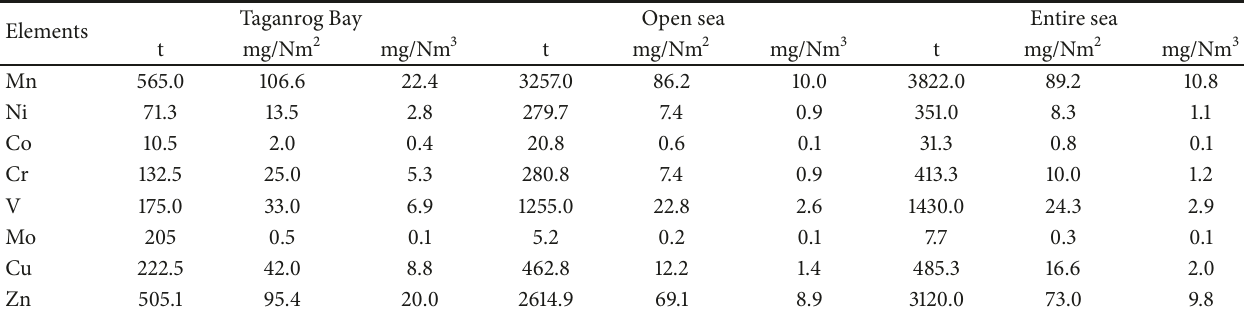
Table 2: The annual consumption of phytoplankton micronutrients in the Azov Sea. Elements